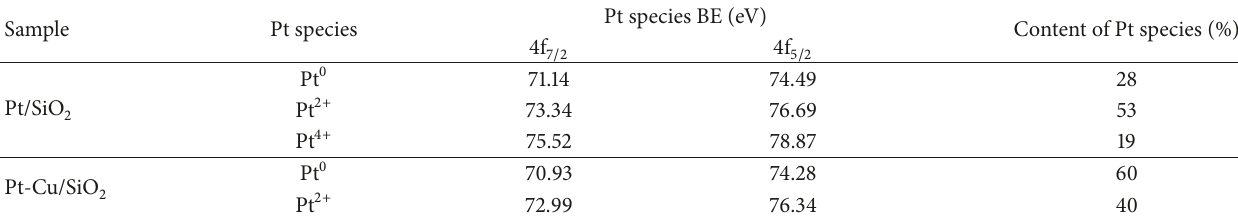
Table 2: Binding energies of the Pt 4f levels and the content of Pt species for the different catalysts.